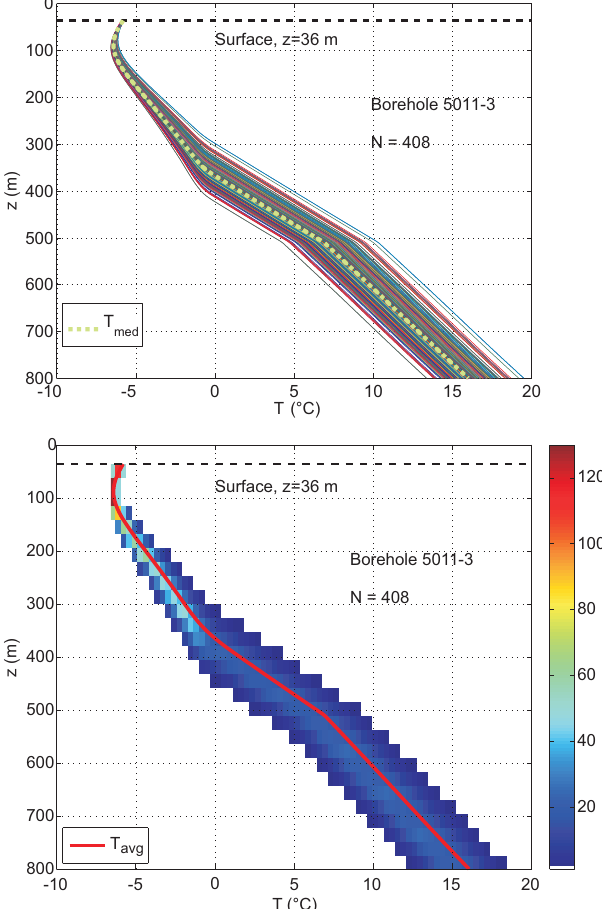
Fig. 10. Results from the MC simulations for the 5011-3 bore- hole. The parameter values assumed are given in Table 6. Top: Line plots of the calculated subsurface temperatures, with the me- dian highlighted. Bottom: corresponding density plot and average temperature profile for the same data